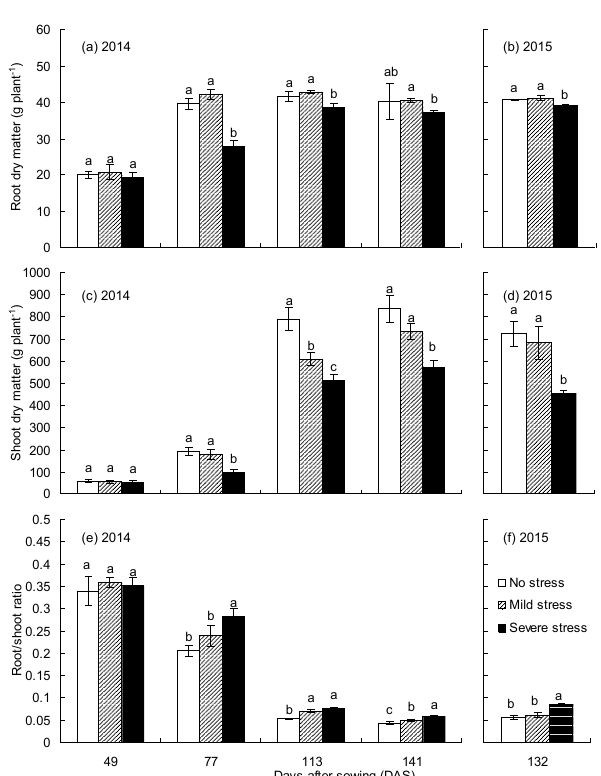
Figure 3. Root and shoot dry matter of maize under water stress at different growing stages in 2014–2015.